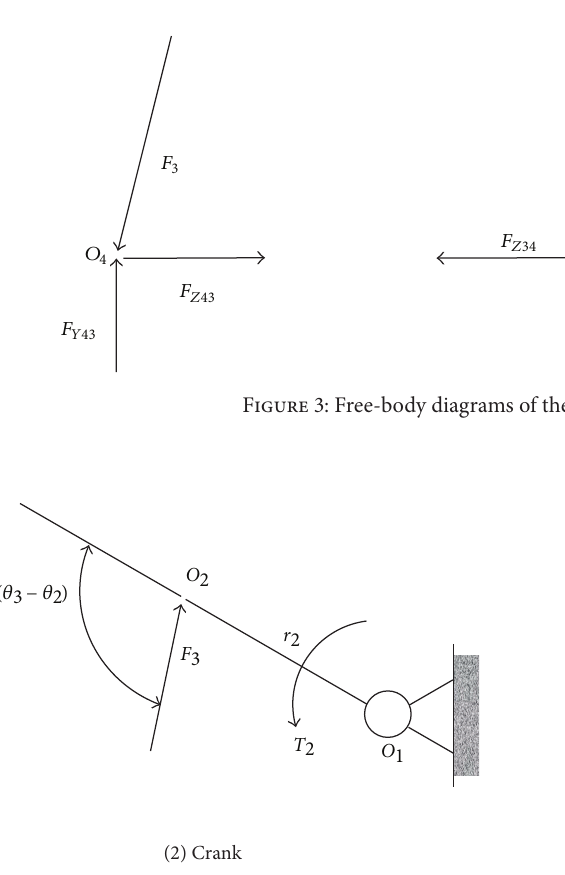
Figure 4: Balance of moments on the crank.